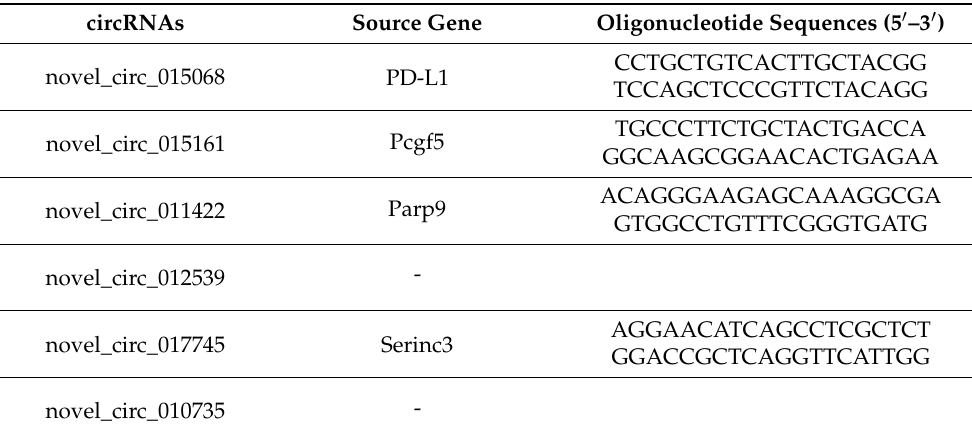
Table 2. Primers used for validating the expression of linear transcripts of